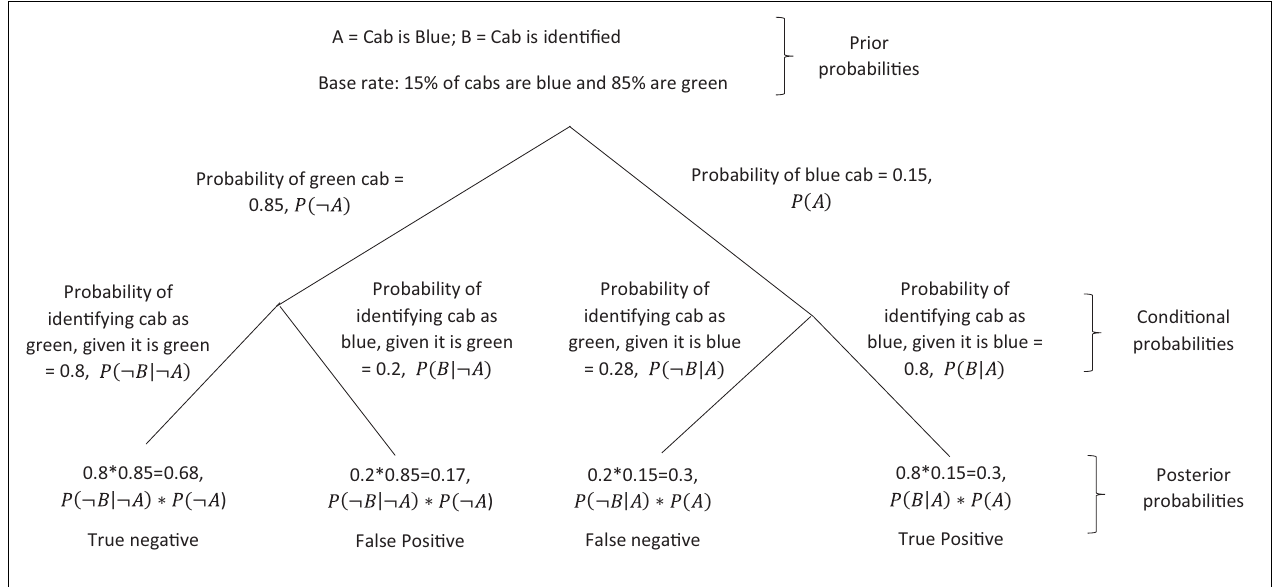
FIGURE 4 | Bayes decision tree highlighting how cognitive bias can occurs with